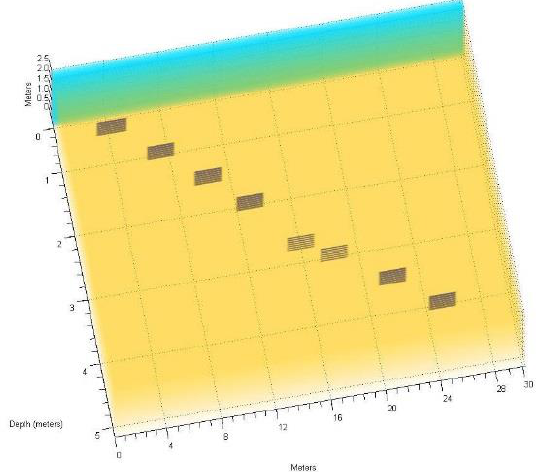
Figure A3. GprMax 3-D model of the Forest Lodge site with eight tin roofing sheets buried objects buried in moist sand including a 0.15-m air space above ground [1,4].